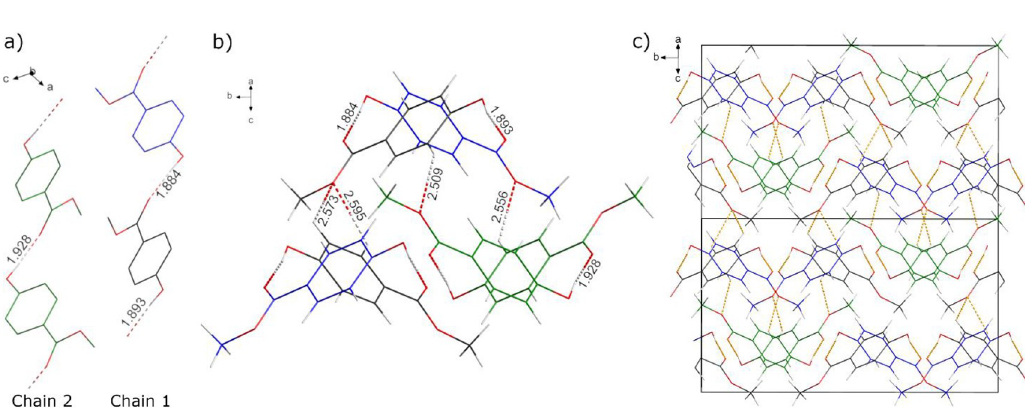
Fig 1. The arrangement of methyl 4-hydroxybenzoate molecules depicted by a wire-stick model. Three independent molecules are shown in black (1), blue (2), and green (3). a) 1D molecular zig-zag chains formed through O-H ��� O hydrogen bonding viewed around the b axis. Chain 1 is formed by alternating molecules 1 and 2, while chain 2 is composed of only molecule 3; b) 1D chains are running parallel to the [101] direction and are connected to each other via C-H ��� O H-bonding. The H-bonding distances are shown on the respective bonds; c) Supramolecular feature of the crystal structure is realized by ... AB ... stacking of ½ 112 � layers along the [102] the 2 1